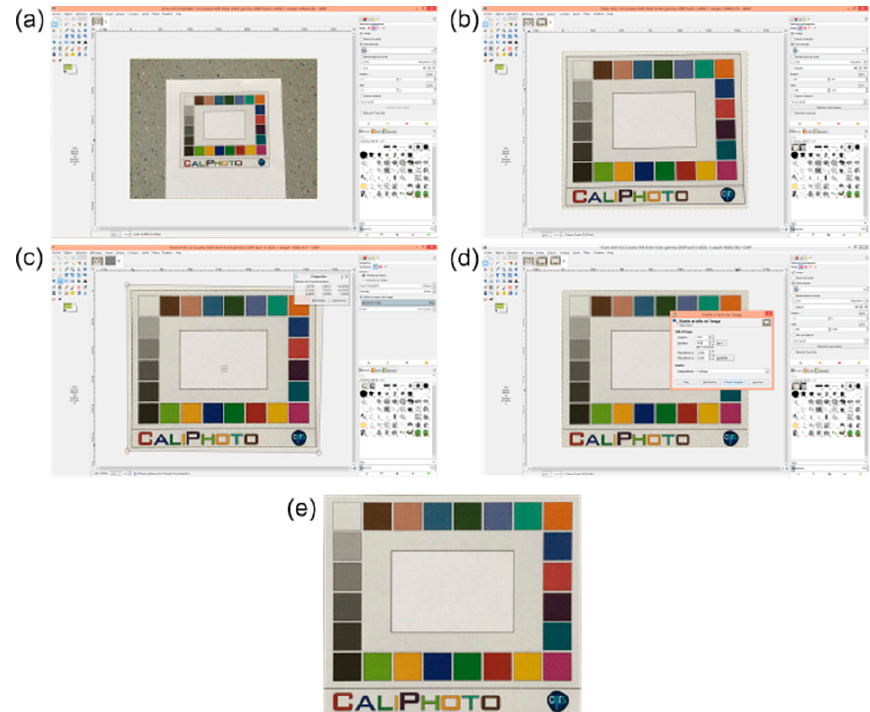
Figure A3. Initial image processing using commercial software (GIMP 2.10). ( a ) Original photograph of the reference image of the colour plate in jpeg format, taken with a tablet camera (iPad), viewed in GIMP software. The area containing the colour plate is selected using the “scrap” tool, copied and pasted as a new image, as seen in ( b ). ( c ) Using the “perspective” tool, the corners of the black